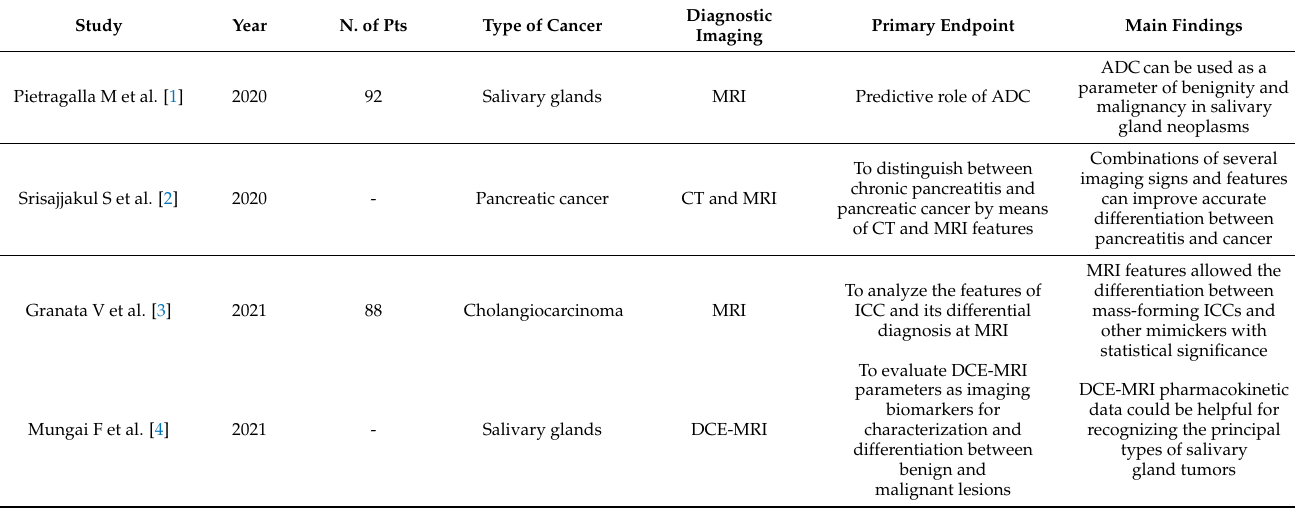
Table 1. Diagnostic imaging and predictive value before cancer treatment in other